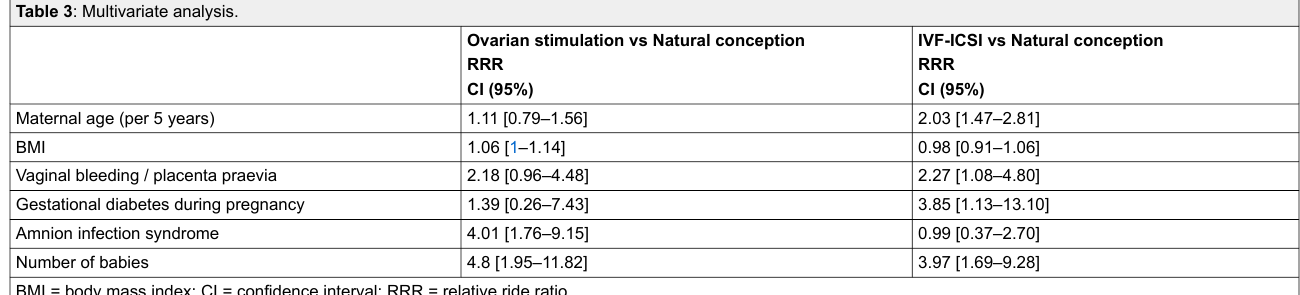
Table 3 : Multivariate analysis.